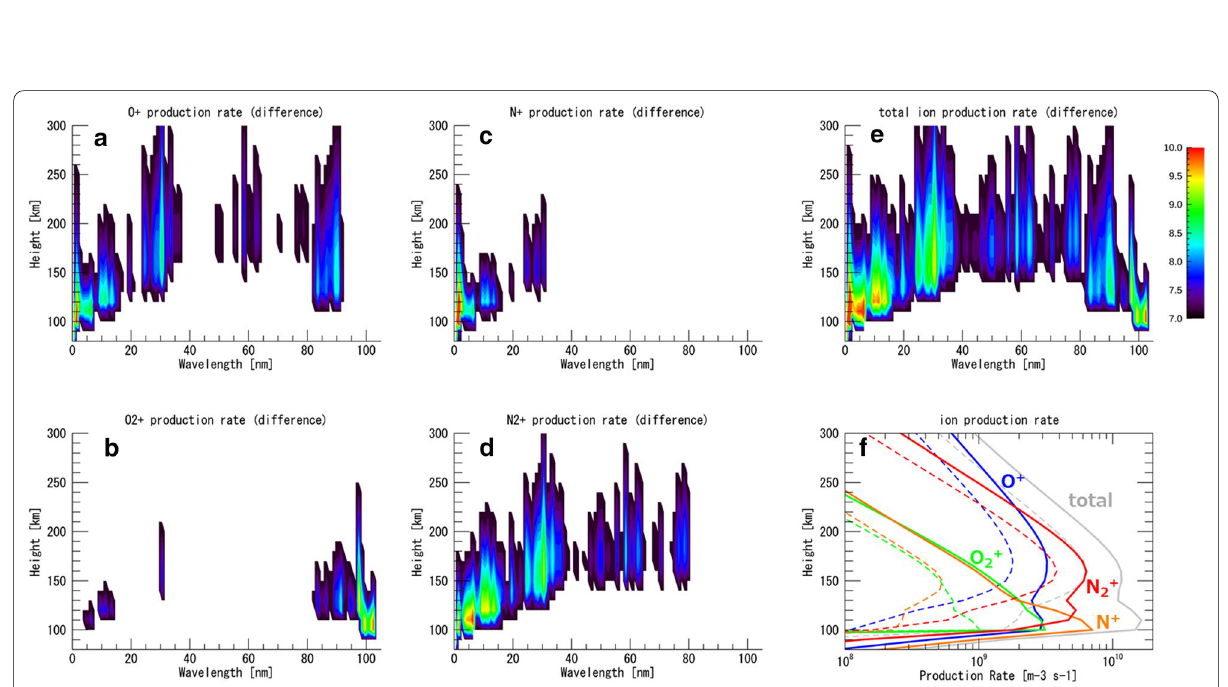
Fig. 6 Difference in ionization rate due to X9.3 flare that occurred in September 6, 2017. The difference in ionization rate of each ion at 0°E and 30°N due to X9.3 flare on September 6, 2017, including ionization by solar irradiance and secondary photoelectrons. The FISM flare spectrum is used for the input spectrum to GAIA. Differences in ionization rate before and after flare for a O + , b O 2 + , c N + , d N 2 + , and e total ion as a function of the wavelength of solar irradiance (unit: Log10(W m − 2 nm − 1 )). f Differences in the altitude distribution of the ionization rate of each ion. Each solid line starts immediately after the flare (12:00 UT), and each dotted line starts before the flare (11:30